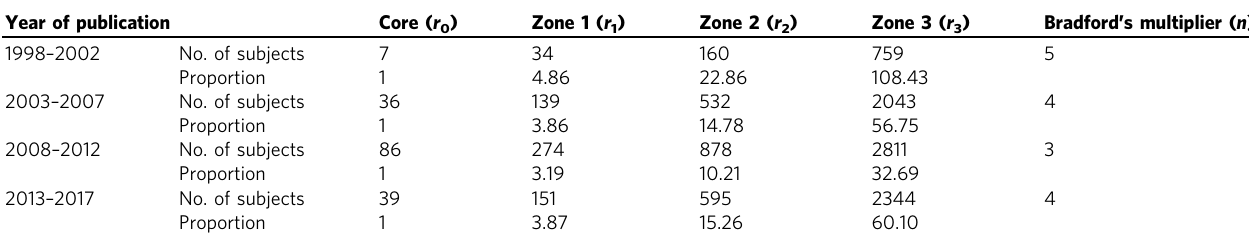
Table 7 Zones and proportions of ICTs subject terms, 1998 –